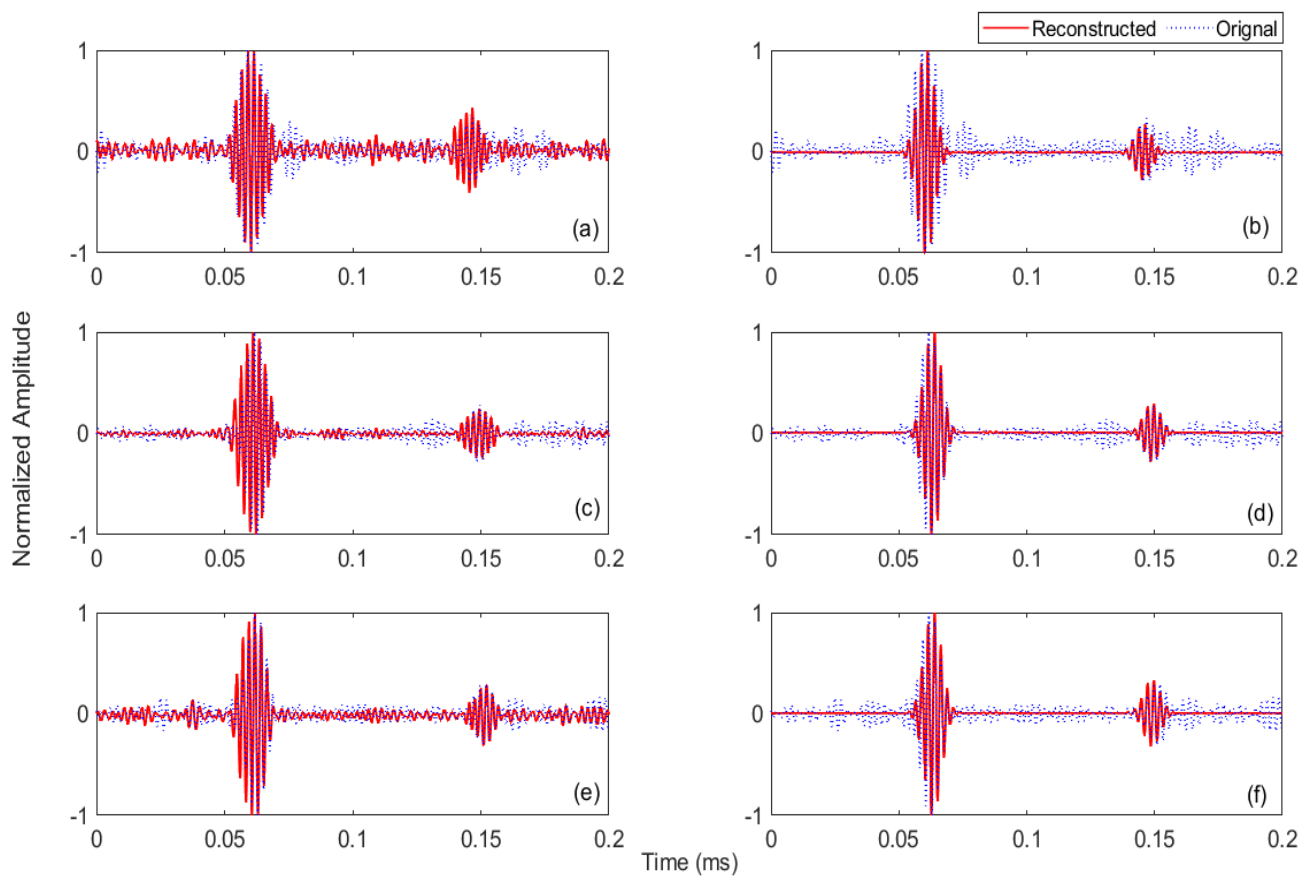
Figure 16. Original day-wise signals captured at specimen B that has a surface horizontal defect and their reconstructed signals after MP with the experimental dictionary: ( a ) day 1, ( c ) day 2 and ( e ) day 3; and after MP with the FEM simulation dictionary: ( b ) day 1, ( d ) day 2 and ( f ) day 3. Table 4. Comparison of MP with FEM simulation and experimental dictionaries to locate defects from day 1 to day 3